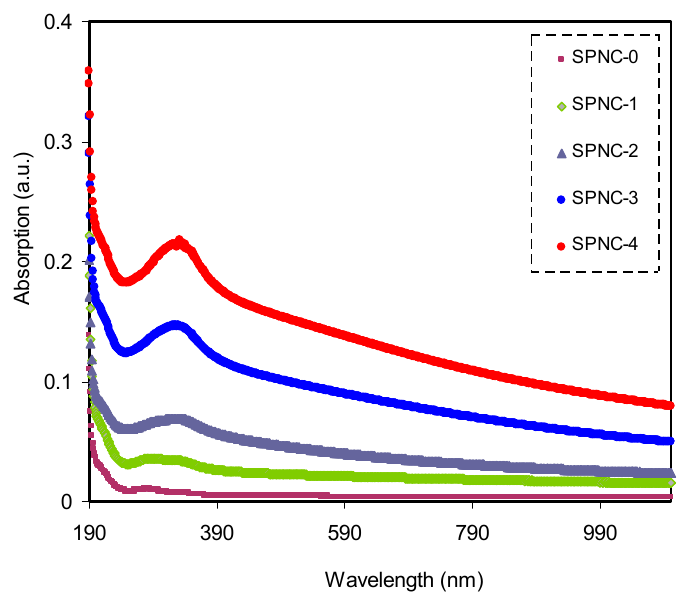
Figure 2. Absorption enhancement in doped samples compared to pure PVA. Figure 3. Absorption enhancement in doped samples compared to pure PVA.